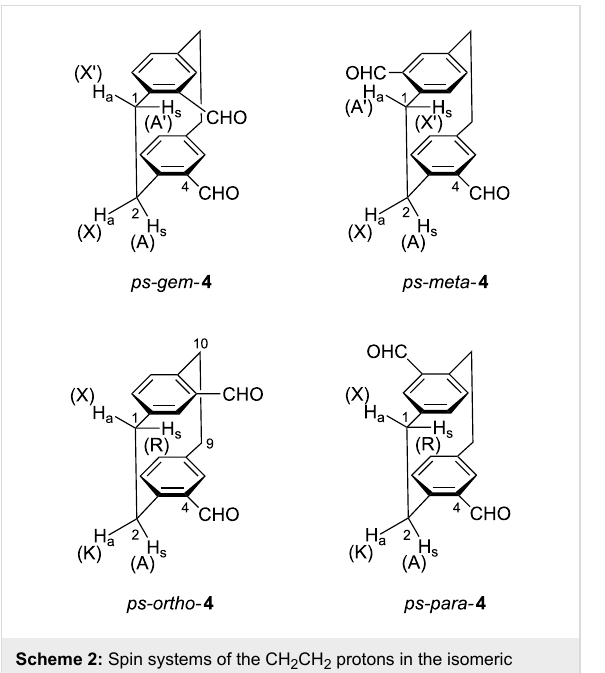
Scheme 2: Spin systems of the CH 2 CH 2 protons in the isomeric dialdehydes 4 . Protons at C-9 and C-10 in ps-gem - and ps-meta - 4 form YY´ZZ´ spin systems, which need not be considered here. Protons at C-9 and C-10 in ps-ortho - and ps-para - 4 form AKRX spin systems equivalent to those of the C-1 and C-2